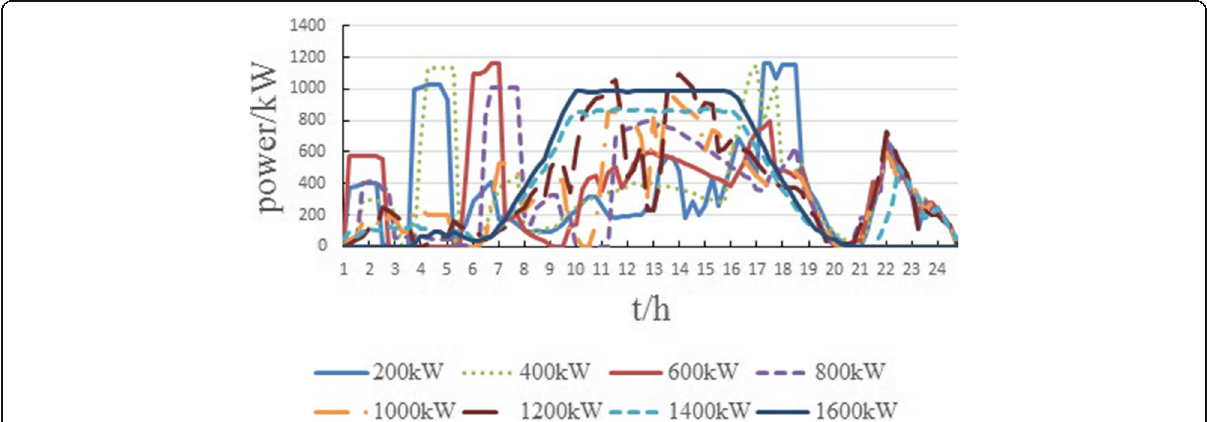
Fig. 14 Charging power curves with different PV capacities (PV bundling requirement = 80%)